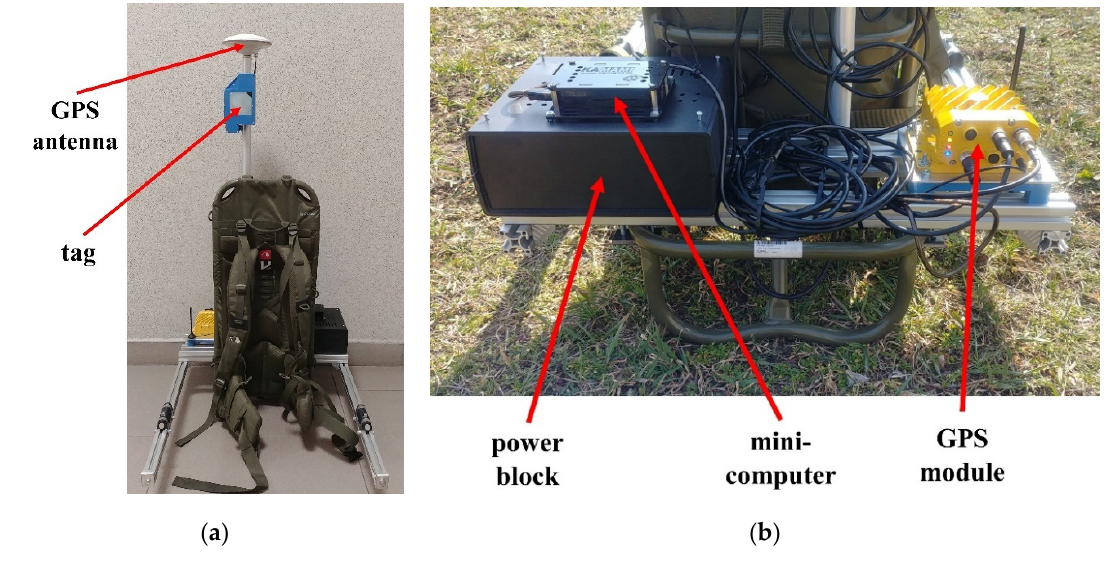
Figure 4. Guide backpack: ( a ) front view and ( b ) rear view.